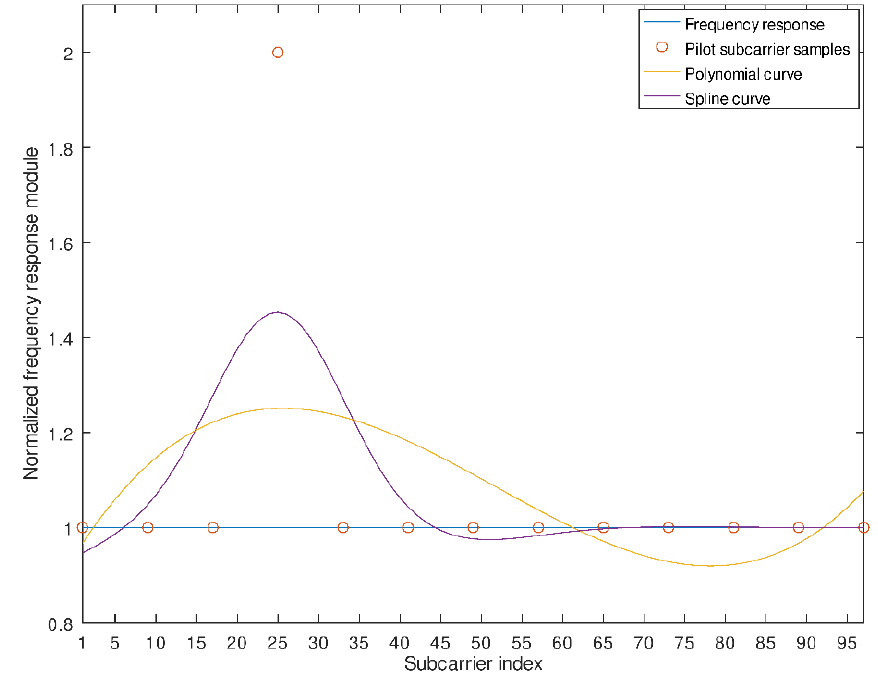
Figure 2. Comparison of spline (purple) and polynomial curve fitting (yellow) channel estimation, over a flat channel frequency response (blue) whose pilot tones (red) are impaired by tonal noise. The values in the Y -axis are given in linear units and normalized to the average frequency response.